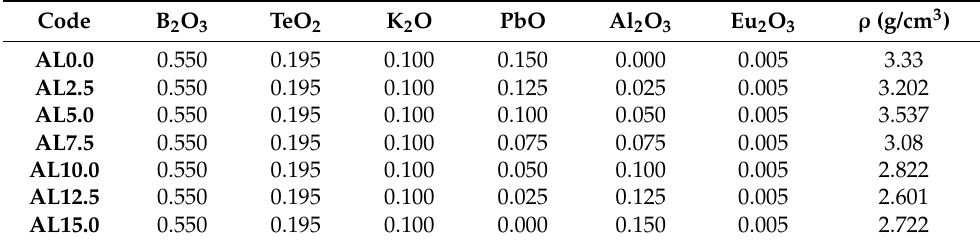
Table 1. Elemental compositions (%mole) of the studied glass samples.